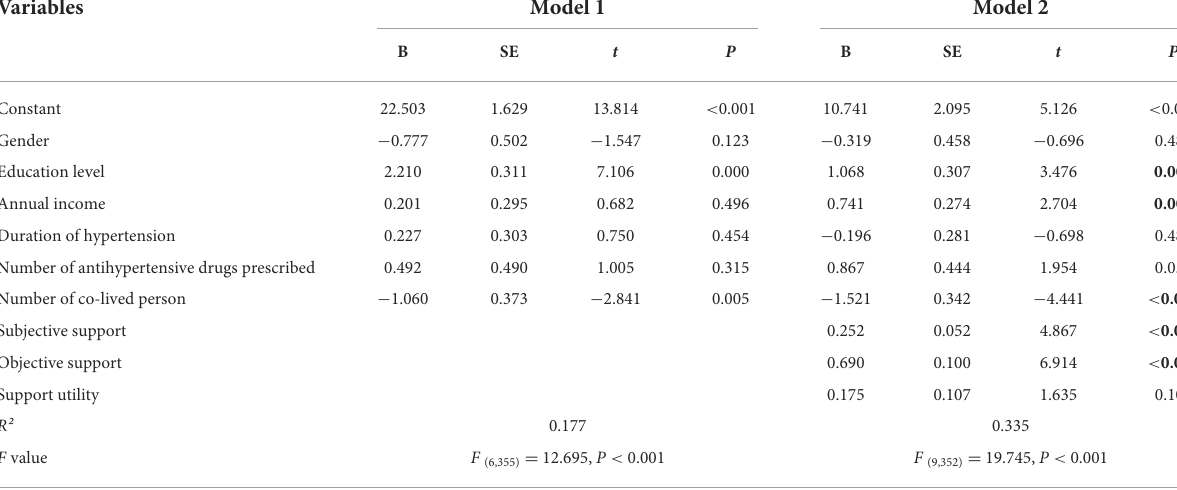
TABLE 4 Hierarchical linear regression analysis of factors influencing medication literacy ( n =